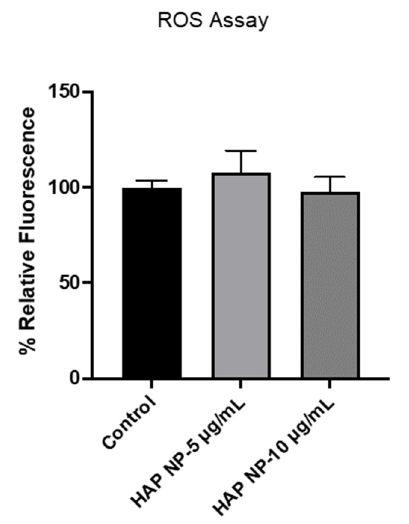
Figure 5. Effects of HAP nanoparticles on oxidative stress induction in hBMVEC was assessed with DCFH-DA assay. Brain endothelial cells were treated with HAP NPs (5 µg/mL or 10 µg/mL) for 48 h and cells were stained with DCFH-DA analyzed. Particles containing up to 10 µg/mL equivalent plasmin concentration showed no oxidative stress effects on the cells.